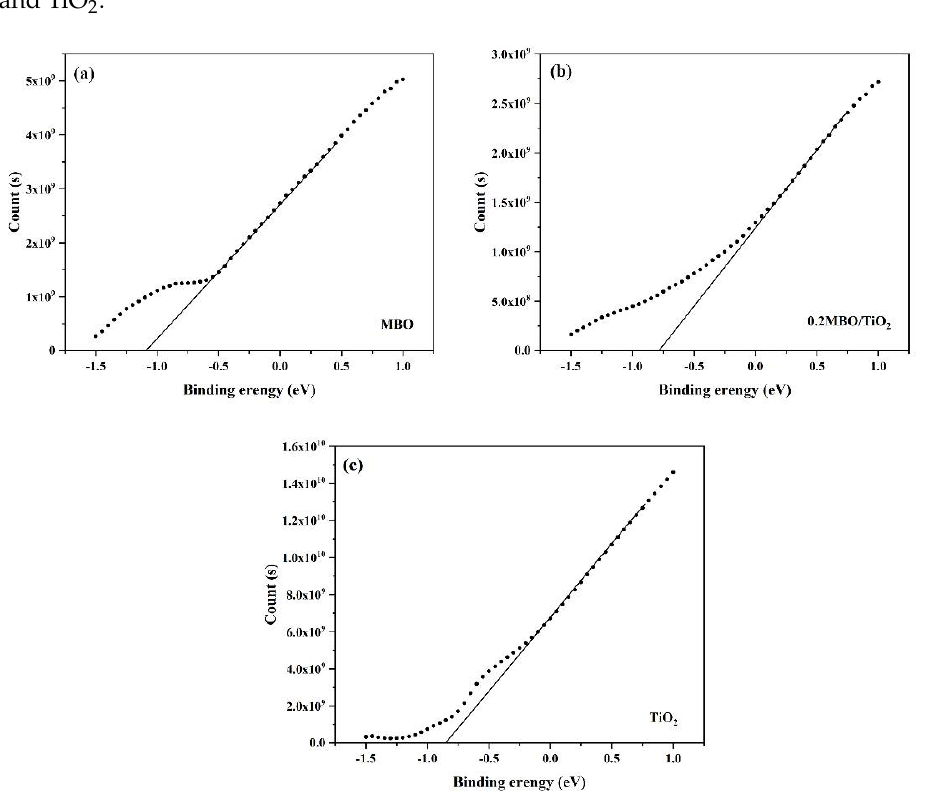
0.96 and 2.61 eV for MBO, and −0.27 and 2.9 eV for TiO 2 , respectively.